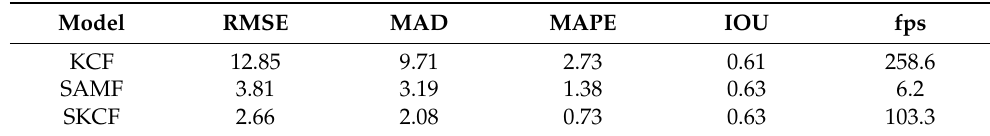
Table 4. Statistical metrics for varied ship trackers on video #2.